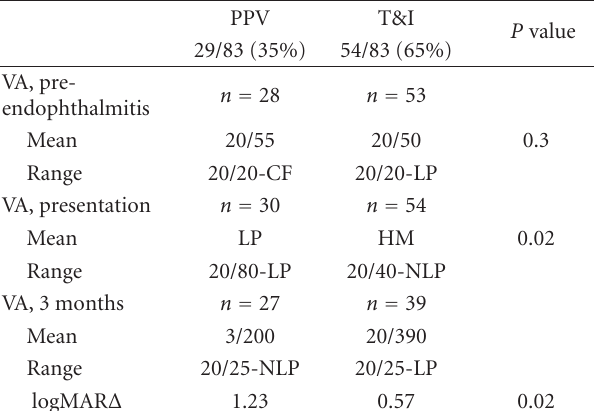
Table 6: PPV versus T&I in present BAE series. Table 7: PPV versus T&I: presentation VA of LP or worse in present BAE